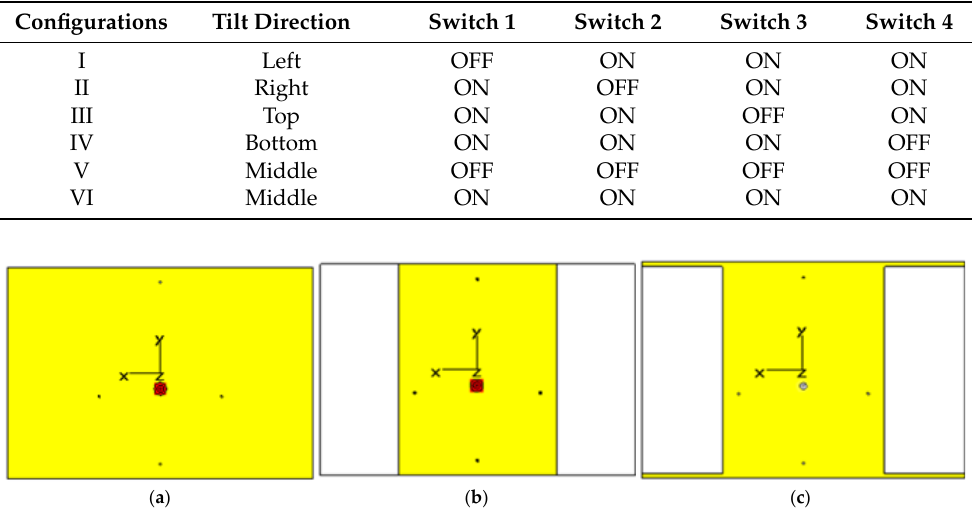
Table 1. Switching configurations of the proposed antenna.